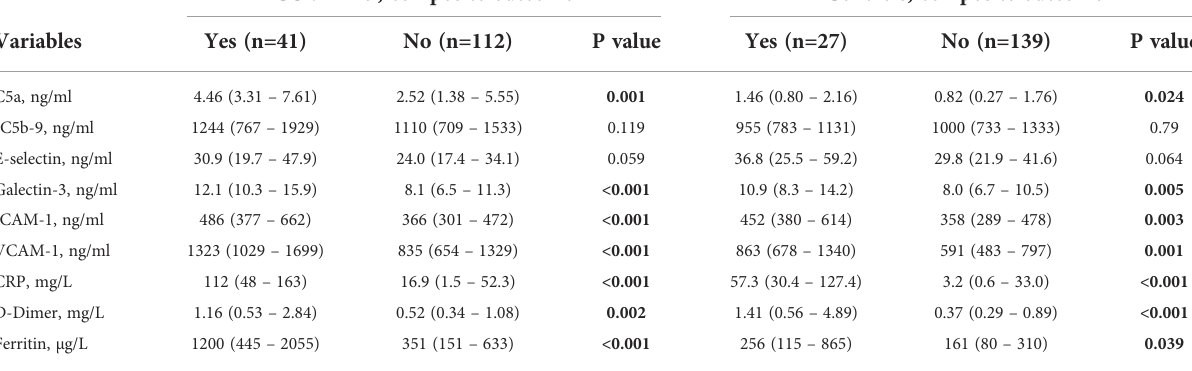
TABLE 4 Concentrations of markers of complement and endothelial cell activation and in fl ammation on admission according to the composite outcome of admission to the intensive care unit or death at 30 days in cases and